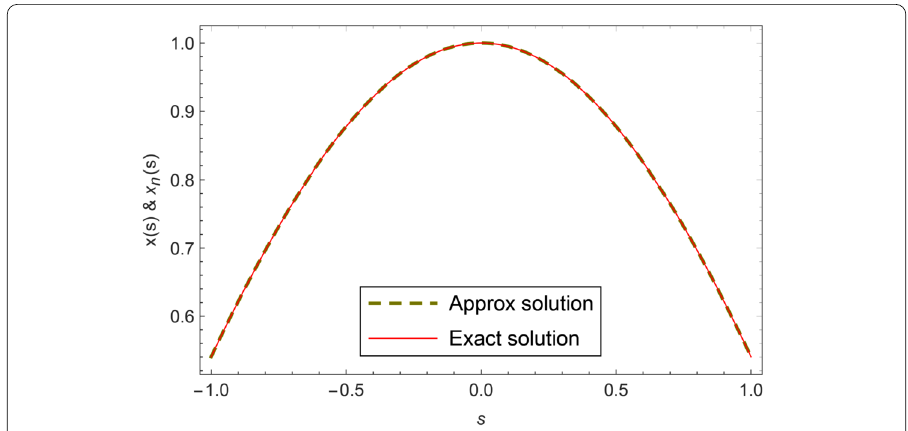
Figure 5 Comparison of solutions for Example 3 with n = 10 and m = 10